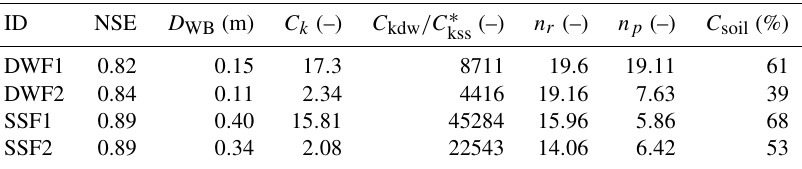
Figure 11. Proportion of surface runoff in the flows at the outlet. Left: The proportion over the whole hydrograph. Right: the proportion at high discharges (observed flow greater than 0.25 times the maximum flow during the event). Table 3. Realistic models and parameter sets for the Hérault catchment at Saint-Laurent-le-Minier (no. 3b). C soil : the contribution to the hydrograph of flows passing through the soil. C kdw /C ∗ : the value of the parameter C kdw for model DWF (Eq. 1) or the value of the kss parameter C ∗ for the model SSF (Eq. kss